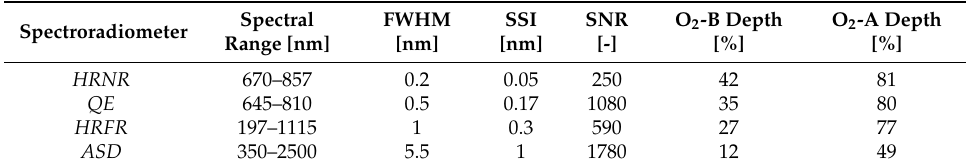
Table 1. The characteristics of each spectrometer are reported in terms of spectral range, spectral resolution (FWHM), spectral sampling interval (SSI), signal to noise ratio (SNR) and percentage depth of the two telluric oxygen absorption